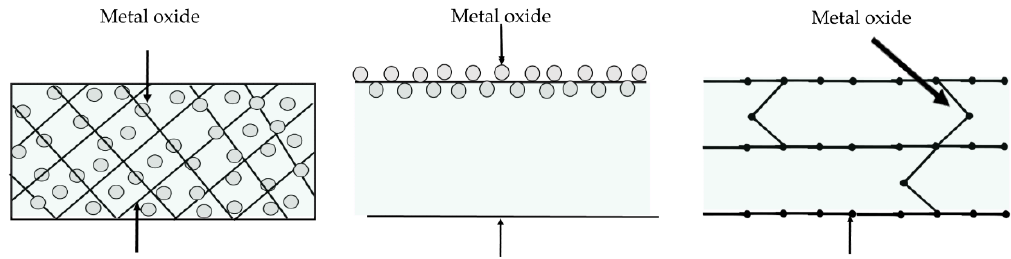
Figure 1. Schematic representation of hybrid composite preparation: ( a ) mechanical stirring, ( b ) coating surface, and ( c ) nanocomposite (adapted from Miyazaki et al. [22]). TiO 2 can be incorporated to different organic matrixes as corn and potato starches, carboxymethyl cellulose, sesame, whey proteins, wheat gluten, cellulose, poly-lactic acid, xanthan and gellan gums, and chitosan (alone or in combination) aimed to form hybrid composites with potential industrial applications, as shown in Table 1. Table 1. Application of some polymers and proteins functionalized with TiO 2 nanoparticles. Material Application Ref.